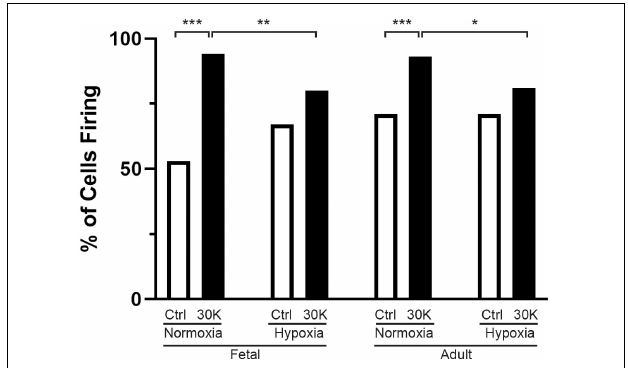
FIGURE 3 | Long-term hypoxia reduces the percentage of basilar arterial myocytes with depolarization mediated Ca 2 + oscillations in fetal and adult sheep. Each bar represents the percentage of cells with Ca 2 + oscillations under control (clear) or with treatment of 30K (black) based on an examination of myocytes in 1,002 µ m 2 regions of interest. Replicates were performed in 3 separate regions per recording for fetal normoxic (3 animals along with 79 control and 71 30K myocytes), fetal hypoxic (4 animals with 91 control and 74 30K myocytes), adult normoxic (3 animals with 69 control and 68 30K myocytes), and adult hypoxic (4 animals with 61 control and 68 30K myocytes) animals. * P < 0.05, ** P < 0.01, *** P < 0.001 indicate significance based on a chi-square